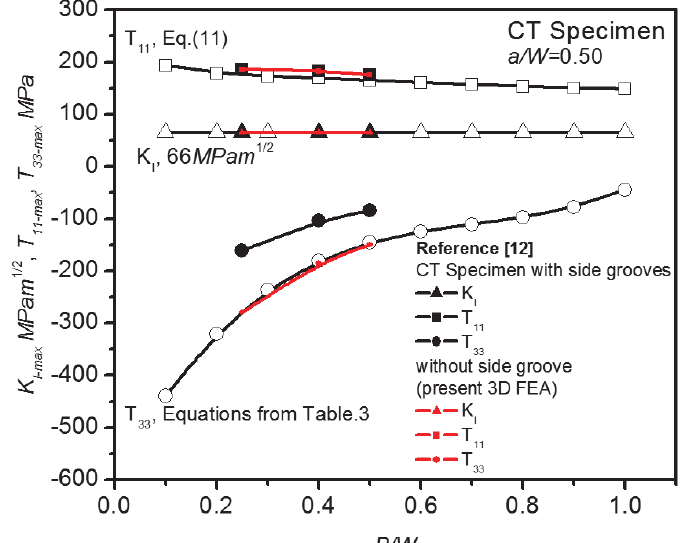
Figure 10: A typical variation of K I-max , T 11-max and T 33-max against B/W obtained by proposed analytical expressions and results of Toshiyuki and Tomohiro